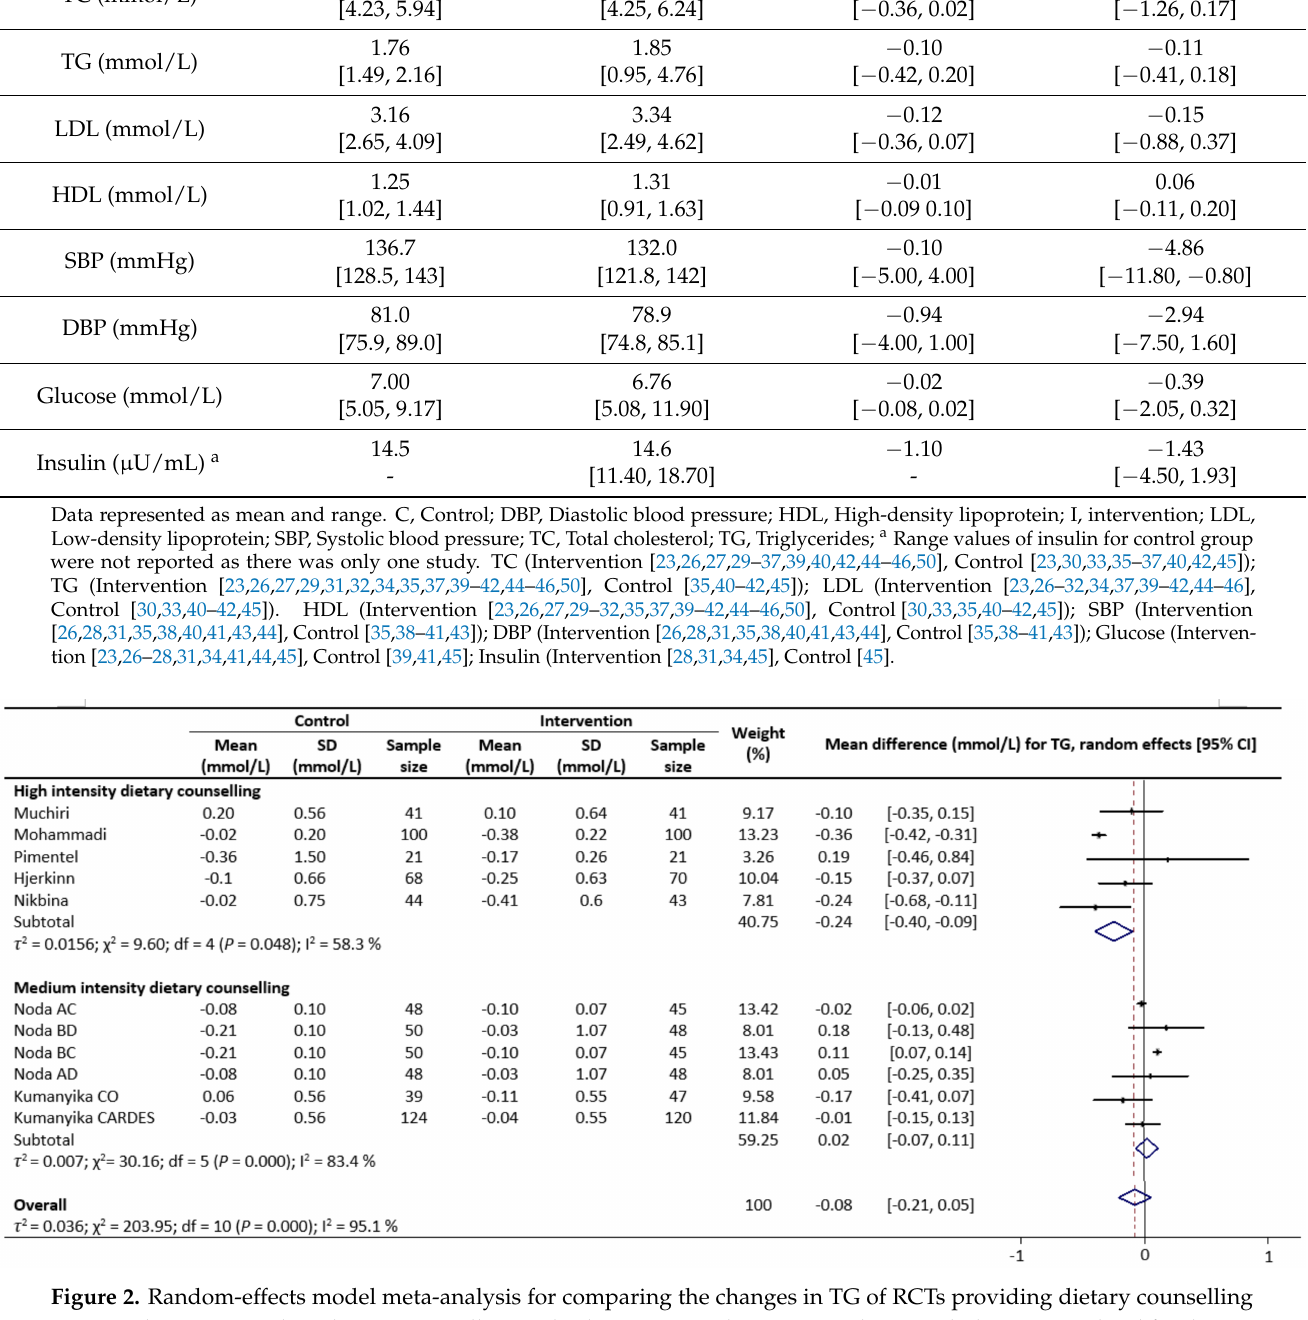
Figure 2. Random-effects model meta-analysis for comparing the changes in TG of RCTs providing dietary counselling compared to not providing dietary counselling and subcategory analysis in accordance with the intensity level for dietary counselling. Each study is identified by author and year. The horizontal line represents the effect size for each study and the whiskers extending on both sides represent the study effect’s 95% CI. The diamond indicates the overall effect size. Abbreviations: AC, group A and group C; BD, group B and group D; BC, group B and group D; AD, group A and group D; CO, counselling only; CARDES, components of cardiovascular dietary education